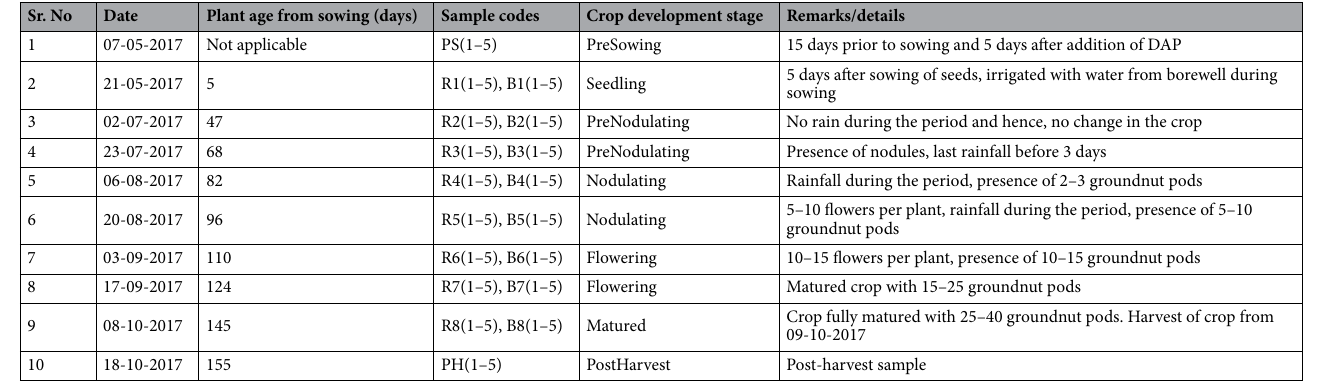
Table 1. Details about the sample